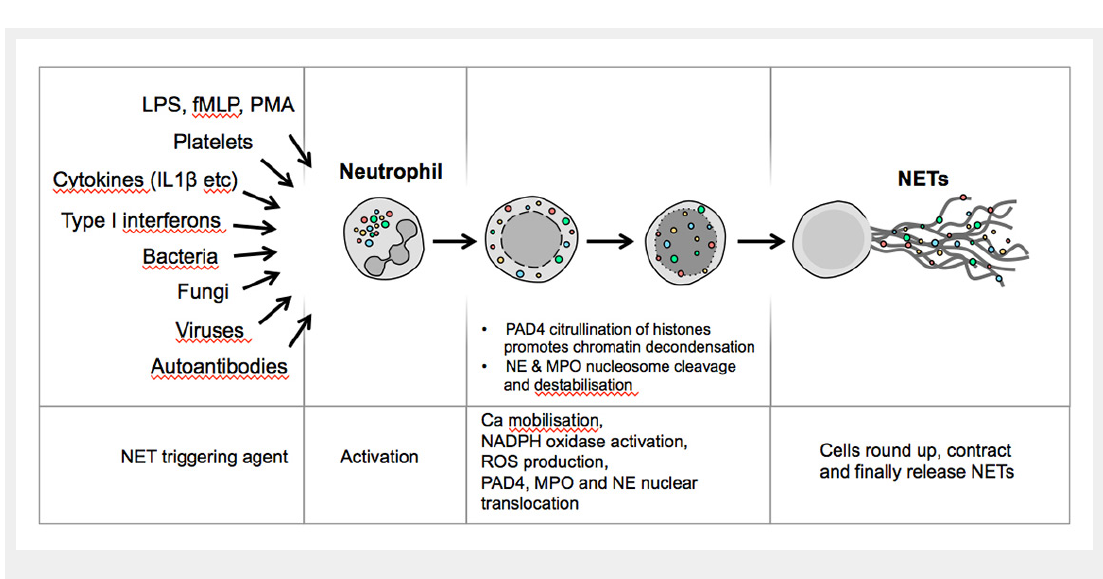
Figure 1 Various stimuli induce neutrophils to form neutrophil extracellular traps. fMLP = N-formyl-methionyl-leucyl-phenylalanine; IL = interleukin; LPS = lipopolysaccharide; MPO = myeloperoxidase; NE = neutrophil elastase; NET = neutrophil extracellular trap; PAD = peptidyl arginine deiminase; PMA = phorbol myristate acetate; ROS = reactive oxygen